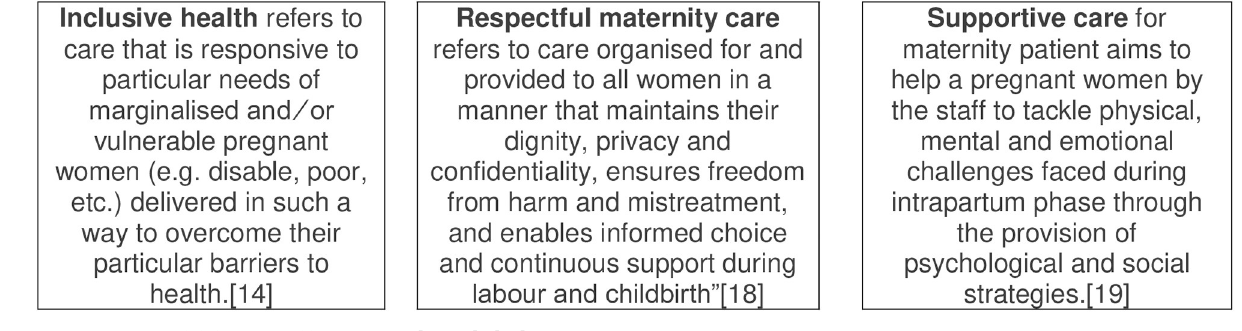
Fig 1. Operational definitions of key concepts [14, 18] a[19].